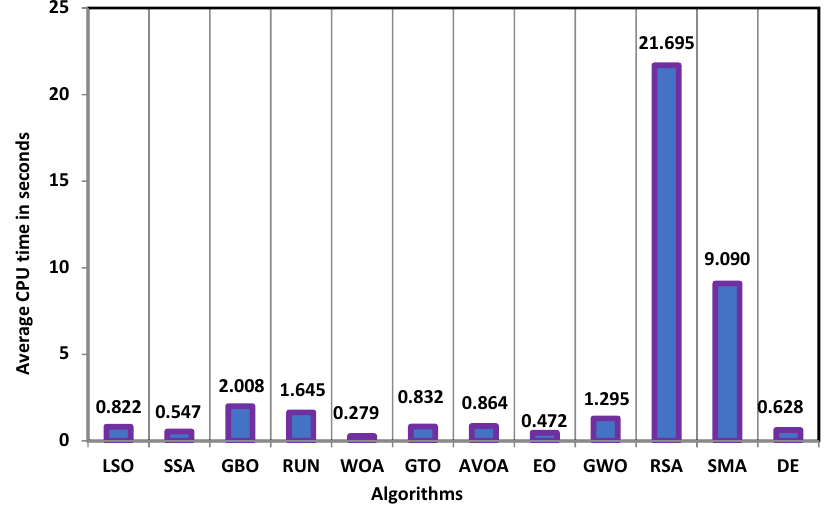
Figure 19. Comparison among algorithms in terms of CPU time .